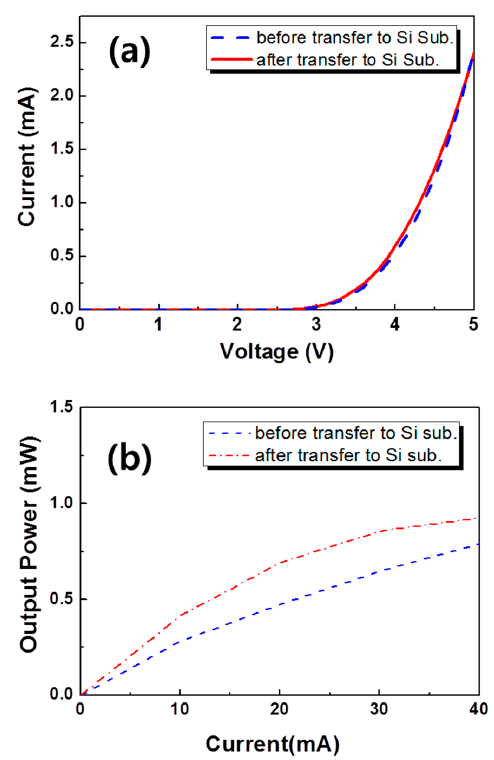
Figure 5. ( a ) I–V curves and ( b ) optical output power of GaN LEDs before and after transfer onto the Si substrate.